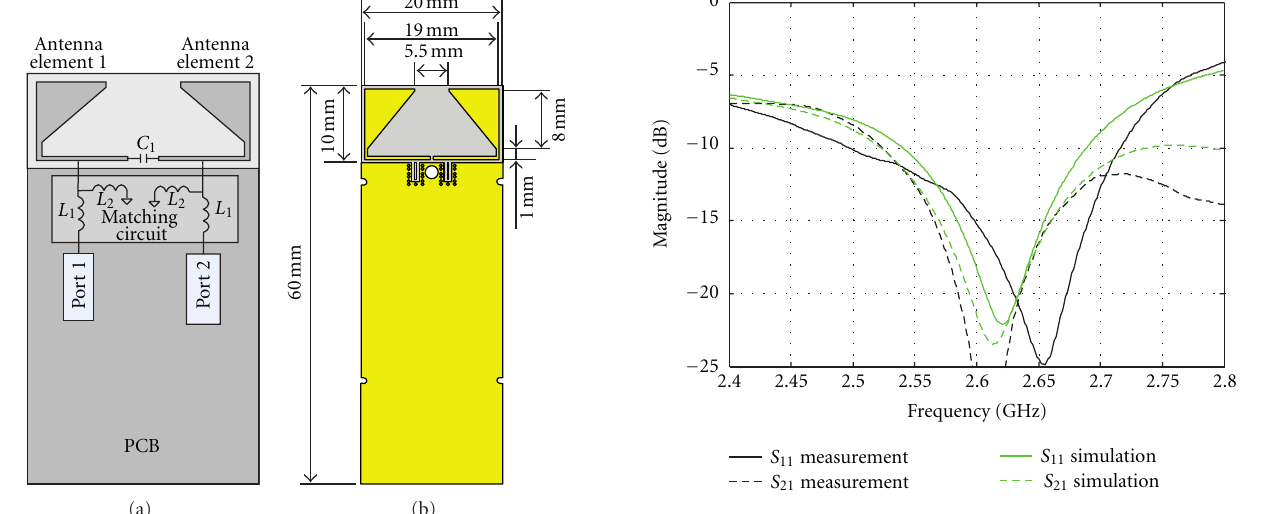
Figure 11: S -parameters of the MIMO antenna system #2 (mea- surements versus simulations).